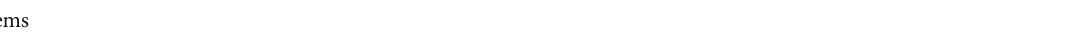
Table 3: Principal component factor analysis with varimax rotation for individual items.